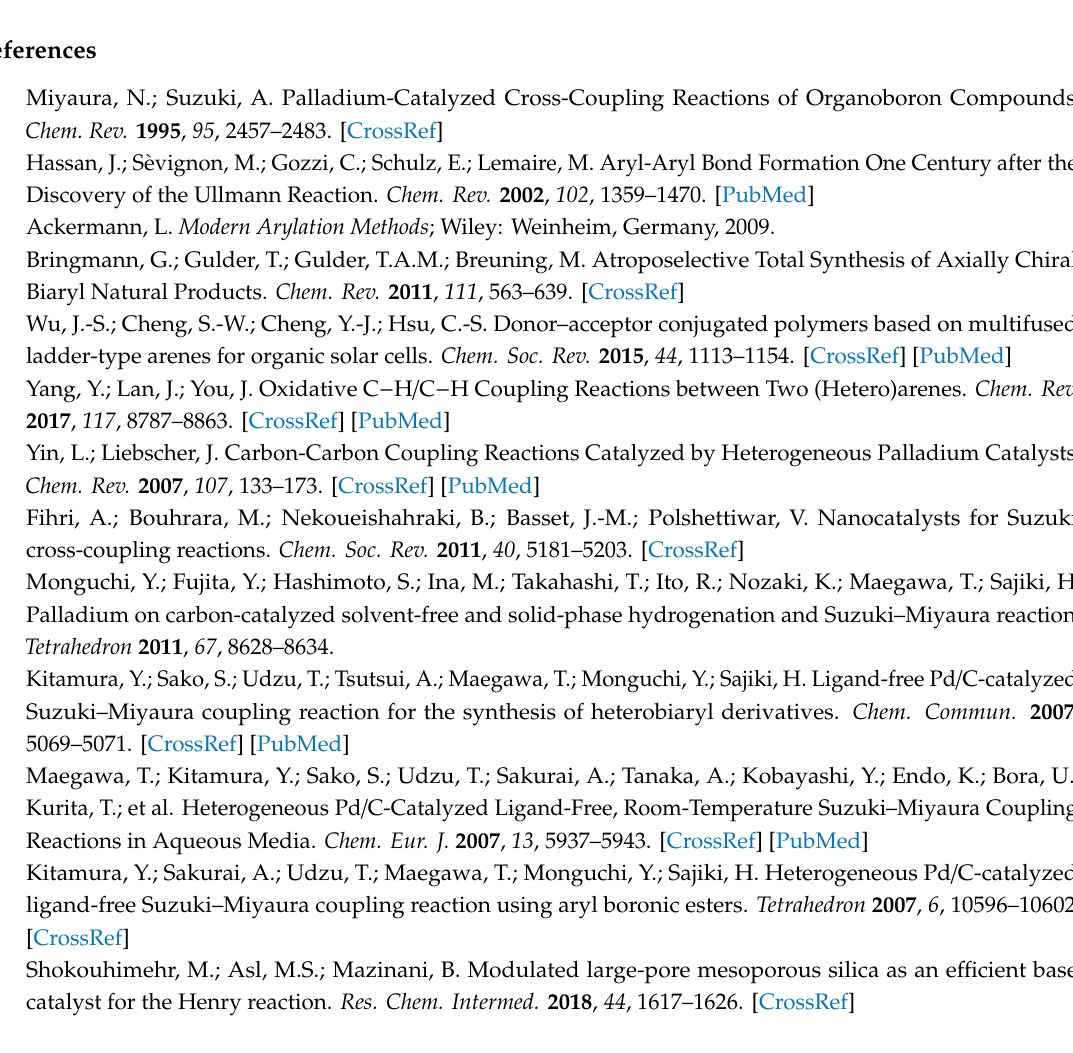
Figure S1. XPS image and curve-fitting of Pd peaks (Cat. D – I ). Figure S2. XPS image and curve-fitting of the Pd peaks of 5% Pd / TiO 2 (Cat. D , anatase-type) before and after use. Table S1. Base e ffi ciency. Table S2. Solvent e ffi ciency. Table S3. Time course